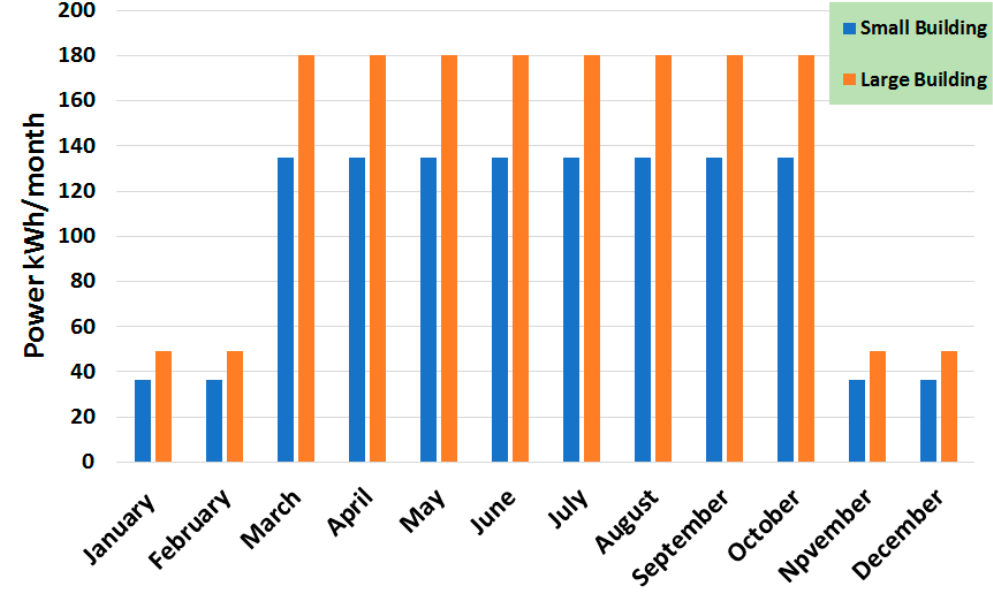
Figure 3. Yearly power consumption differences for two types of primary schools.